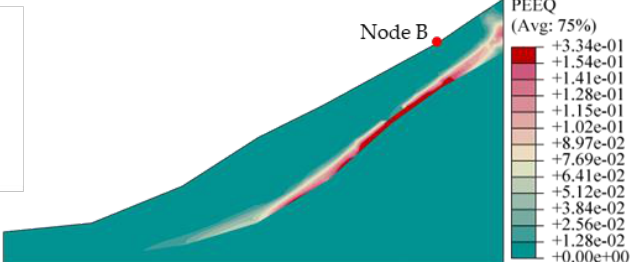
Figure 13. Equivalent plastic strain cloud.